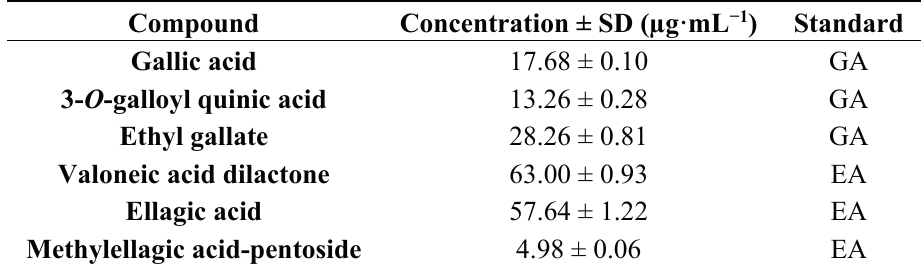
Table 3. Estimation of the contents of phenolic acid derivatives in ethanolic extract from the stem bark of C . ferrea , expressed by the use of linear regression data of gallic acid (GA) and ellagic acid